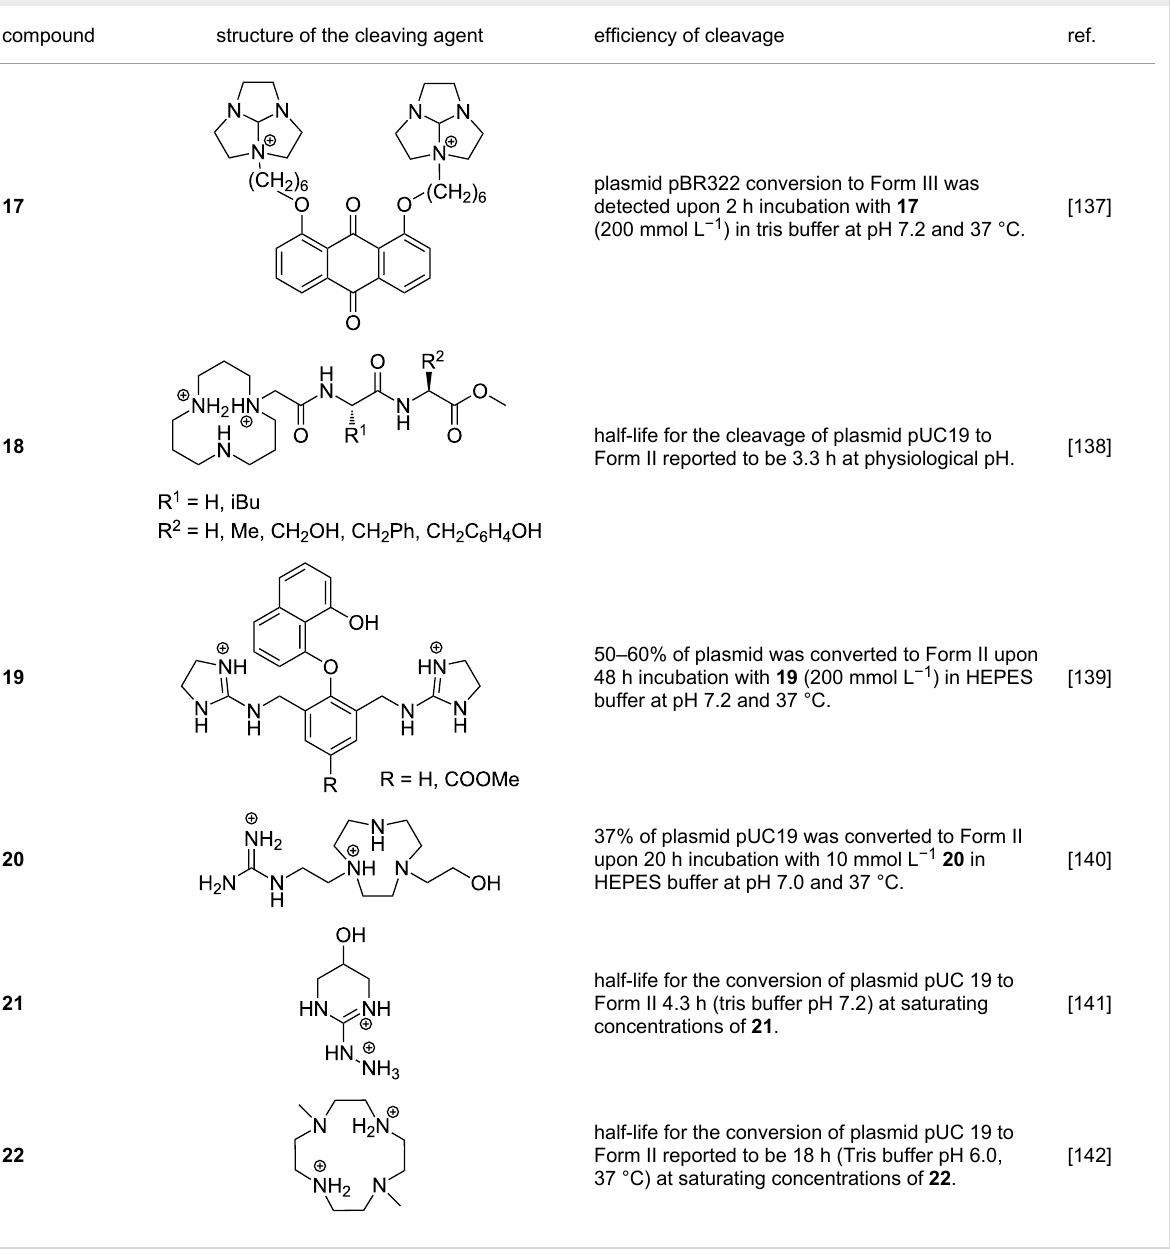
Table 1: Cleavage of supercoiled DNA by nonmetallic cleaving